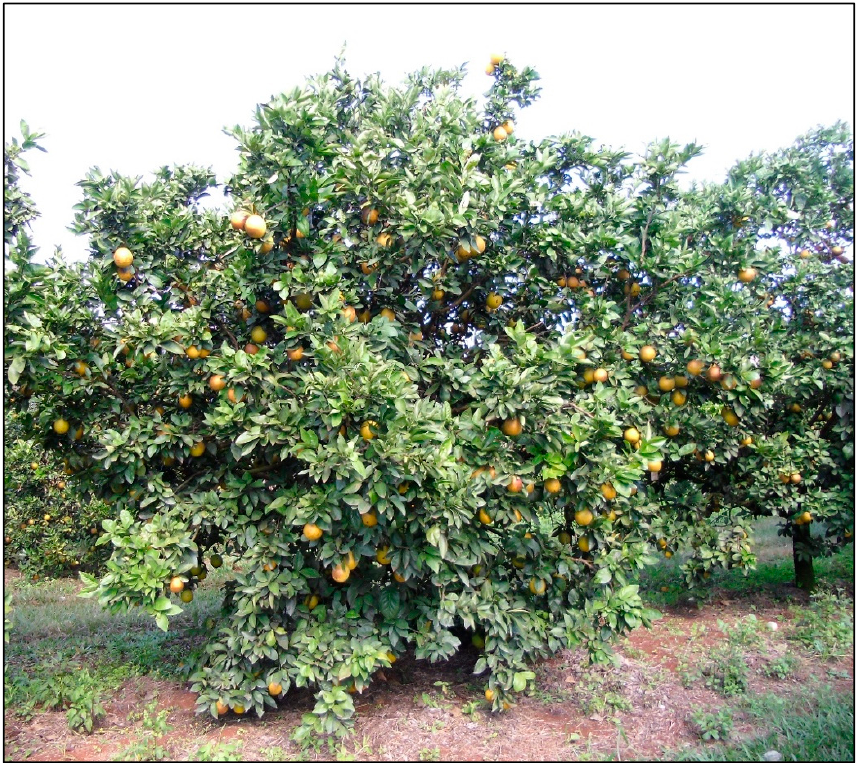
Figure 1. Nine-year-old ‘Shamouti’ sweet orange trees grafted on ‘C-13’ rootstock grown in Londrina, state of Paraná, Brazil.